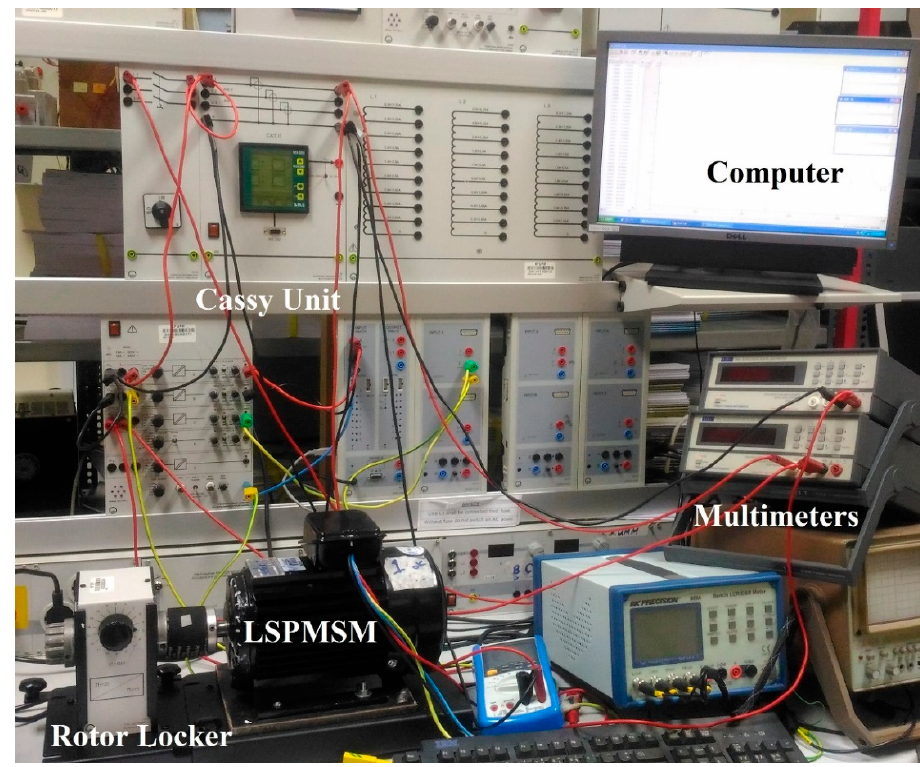
Figure 10. Locked rotor test experimental set-up.